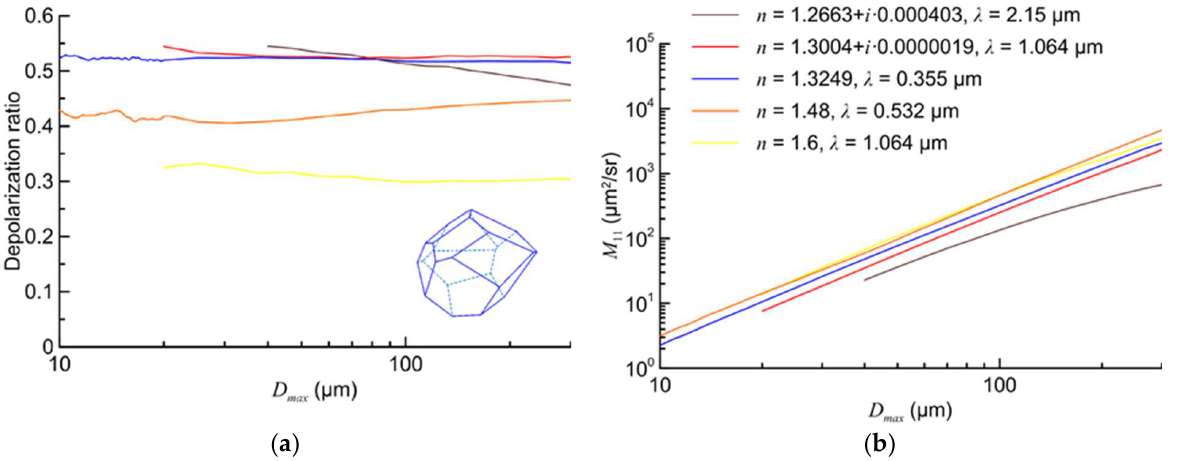
M ( b ) for arbitrary polyhe- 11